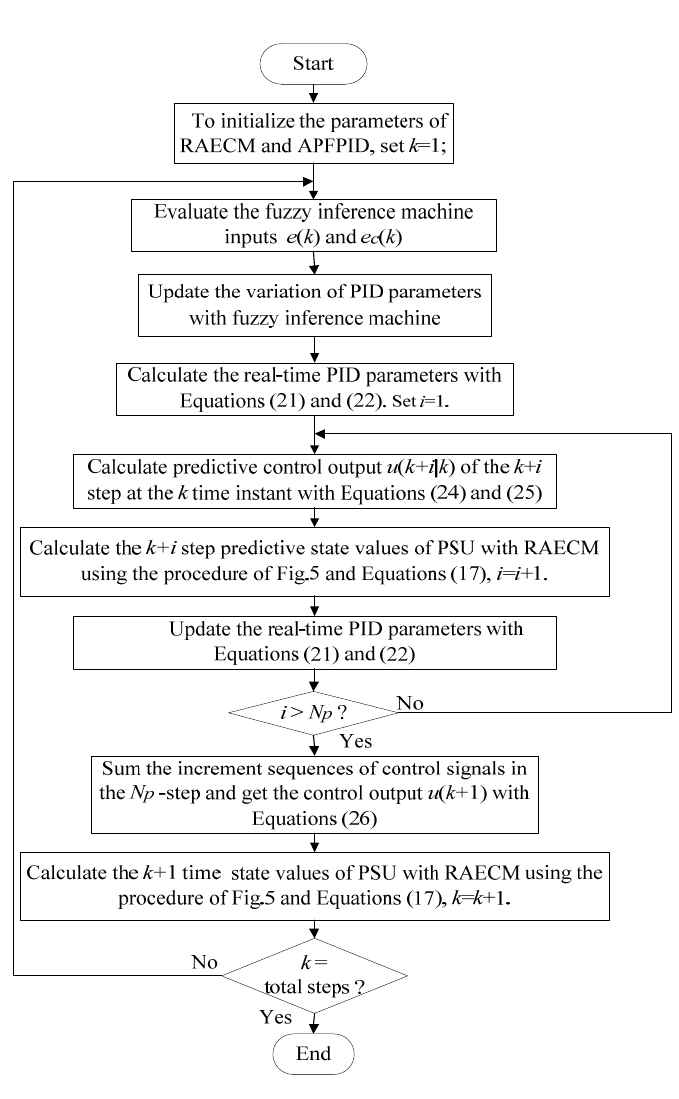
Figure 12. The flowchart of APFPID controller.